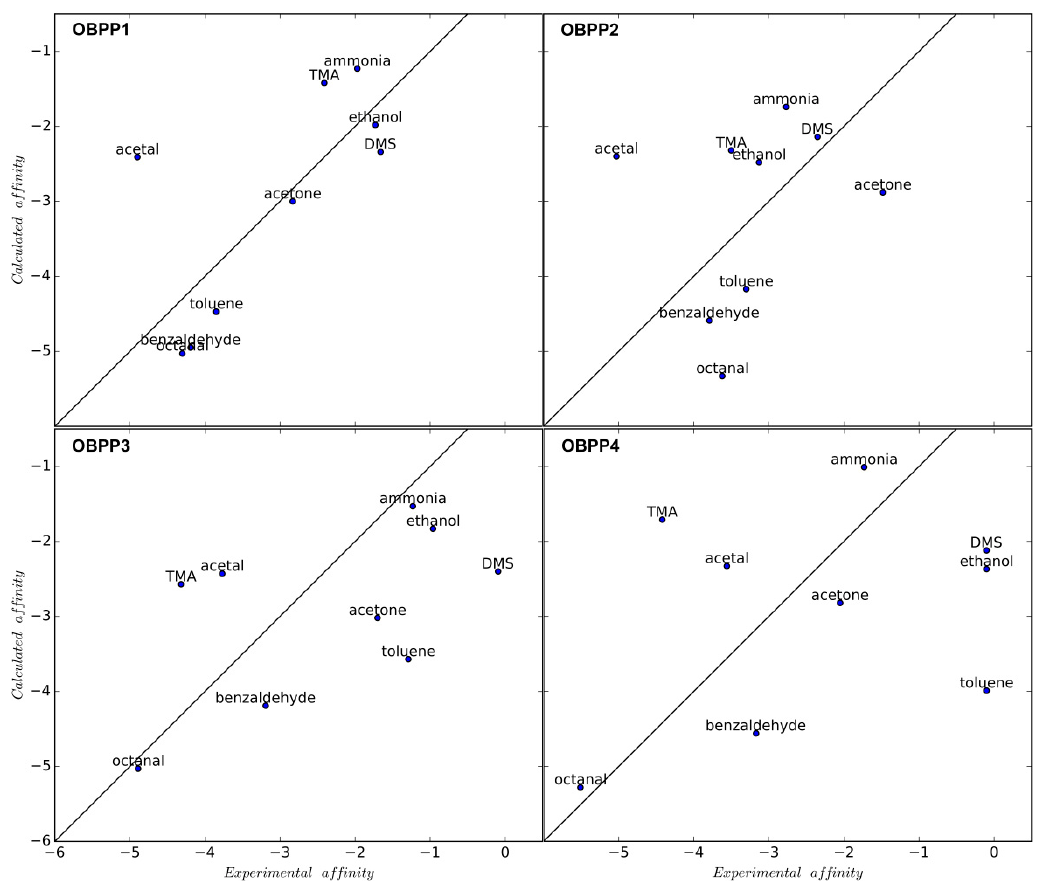
Figure 3. Correlation between experimental and calculated affinities for OBPP1, OBPP2, OBPP3, and OBPP4. The solid lines represent a perfect agreement between the two values. The calculated Pearsons’ correlation coefficients are 0.69, 0.22, 0.56, and 0.33 respectively. The calculated affinity is given as reported by Autodock’s binding affinity, and the experimental affinity value is calculated as 0.8*ln( ∆ F).